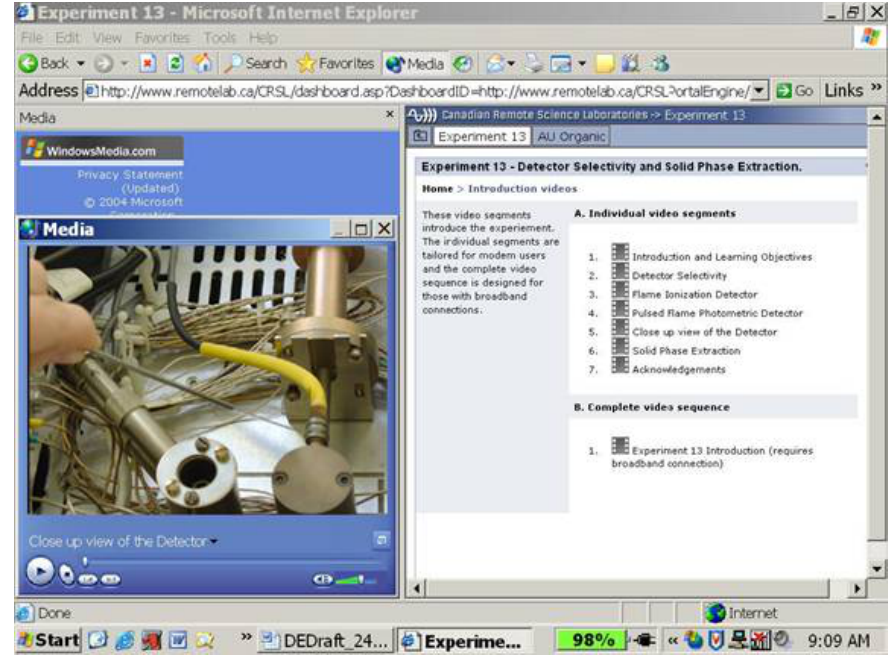
Figure 2. Streaming video demonstrating the instrument within the tutorial